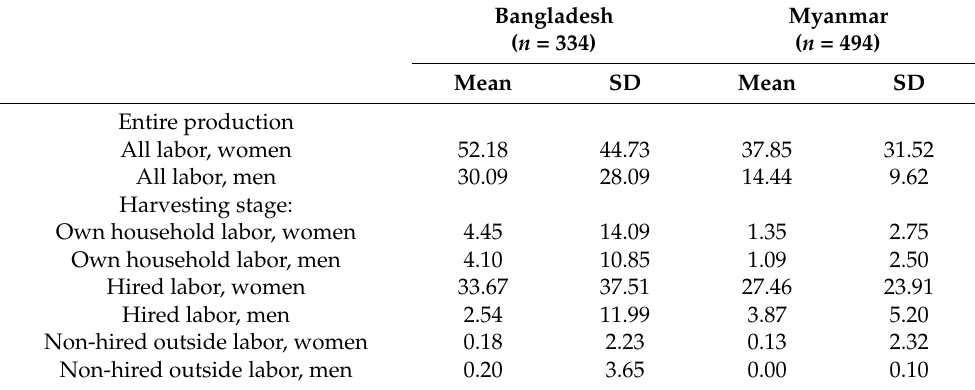
Table 4. Labor use in mungbean production and harvesting in Bangladesh and Myanmar, in standard 8-h working days per hectare,